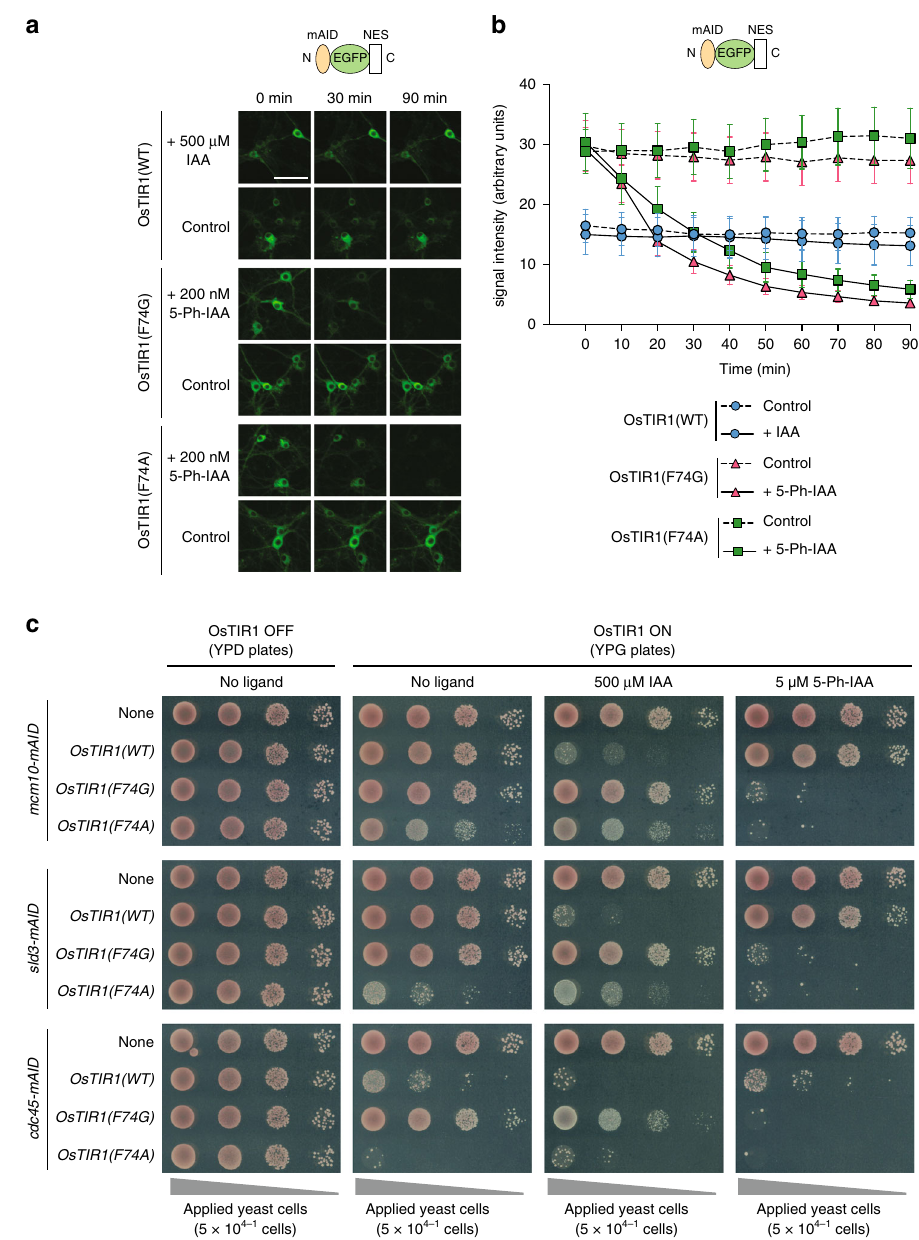
Fig. 2 The AID2 systems work in mouse neurons and yeast. a Mouse hippocampal neurons expressing an mAID-EGFP-NES reporter together with OsTIR1 (WT, F74G or F74A) were treated with the indicated ligand and time-course images were taken. We repeated each experiment at least twice and obtained similar results. Scale bar shows 50 µ m. b A graph was drawn using the quanti fi ed EGFP signal from 30 cells. Data are presented as mean values of 95% con fi dence interval ( n = 30 cells examined). c Haploid yeast lines having the indicated genotype were spotted on YPD (OsTIR1 OFF), YPG (OsTIR1 ON) and YPG containing 500 µ M IAA or 5 µ M 5-Ph-IAA. The plates were incubated at 25 °C for 2 (YPD plates) or 3 days (YPG